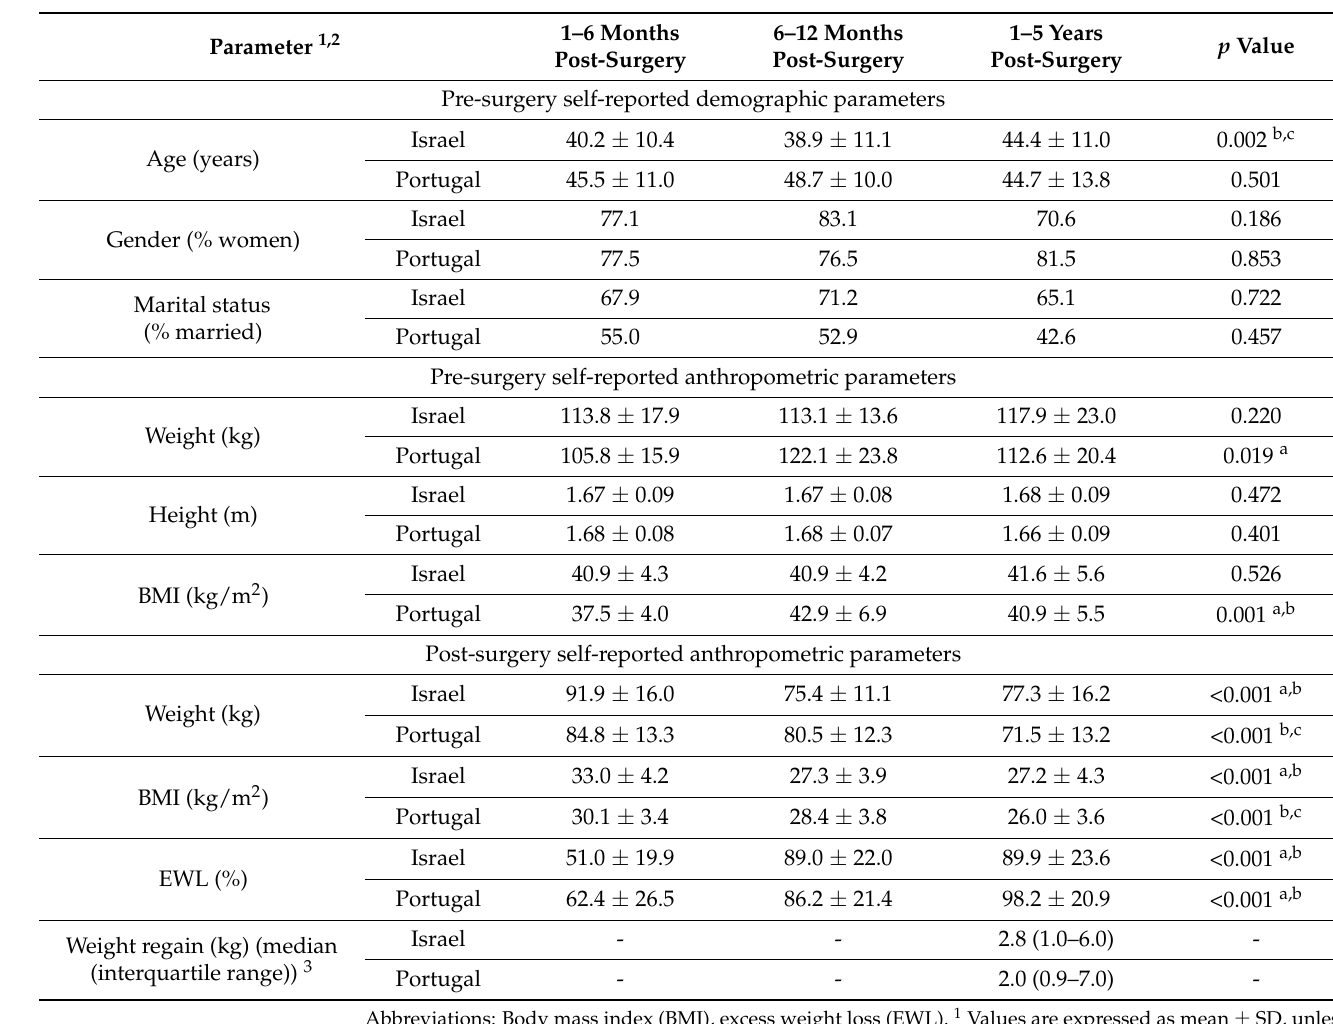
Table 1. Self-reported demographic and anthropometric parameters grouped by time elapsed since surgery and by